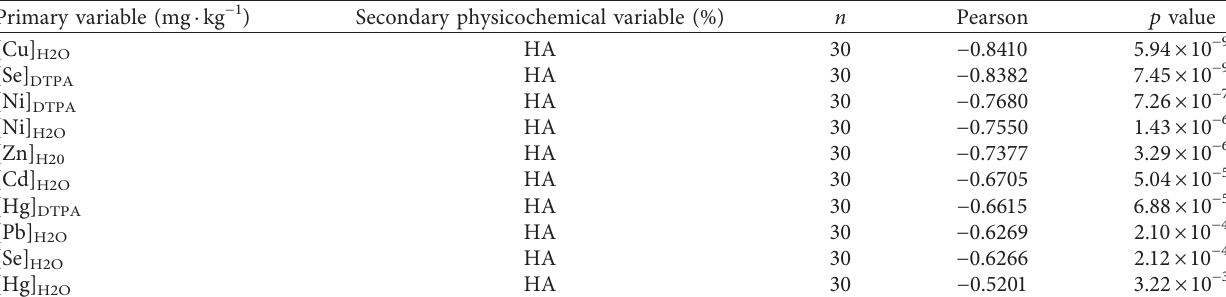
Figure 10: Total concentrations, extracted with DTPA and extracted with deionized water, of Cu, Pb, and Zn during the composting of cattle manure and tree litter in IBM and NMB piles. Between points on the lines with different letters the differences are statistically significant ( p < 0.05). Table 7: Negative values of Pearson’s correlation between primary variables and the AH, with significance without influence of the inoculation factor.